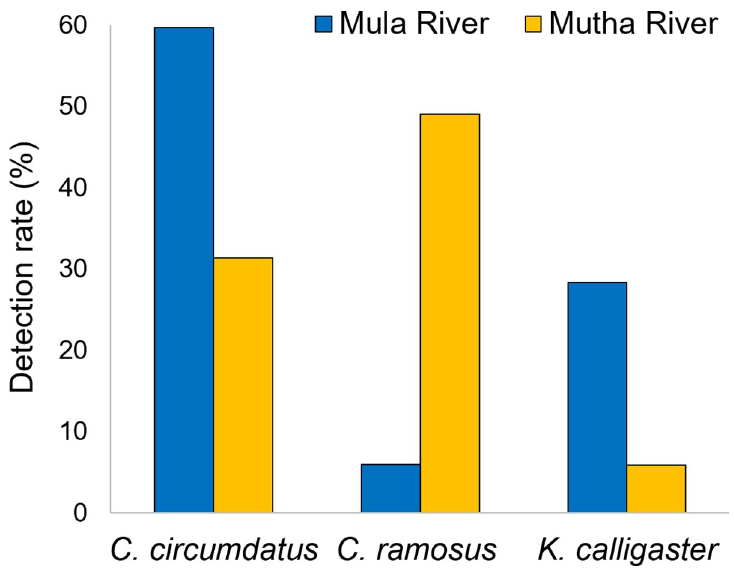
Fig 1. Chironomid species relative abundance (%) in Mula and Mutha Rivers, India.